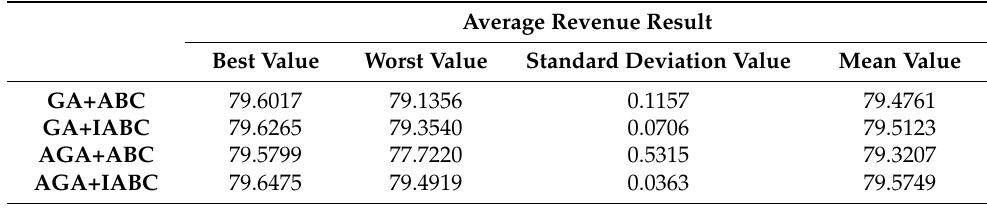
Table 20. Statistical results of average revenue, average cost, average processing time, and average path length using different mission assignment and path planning